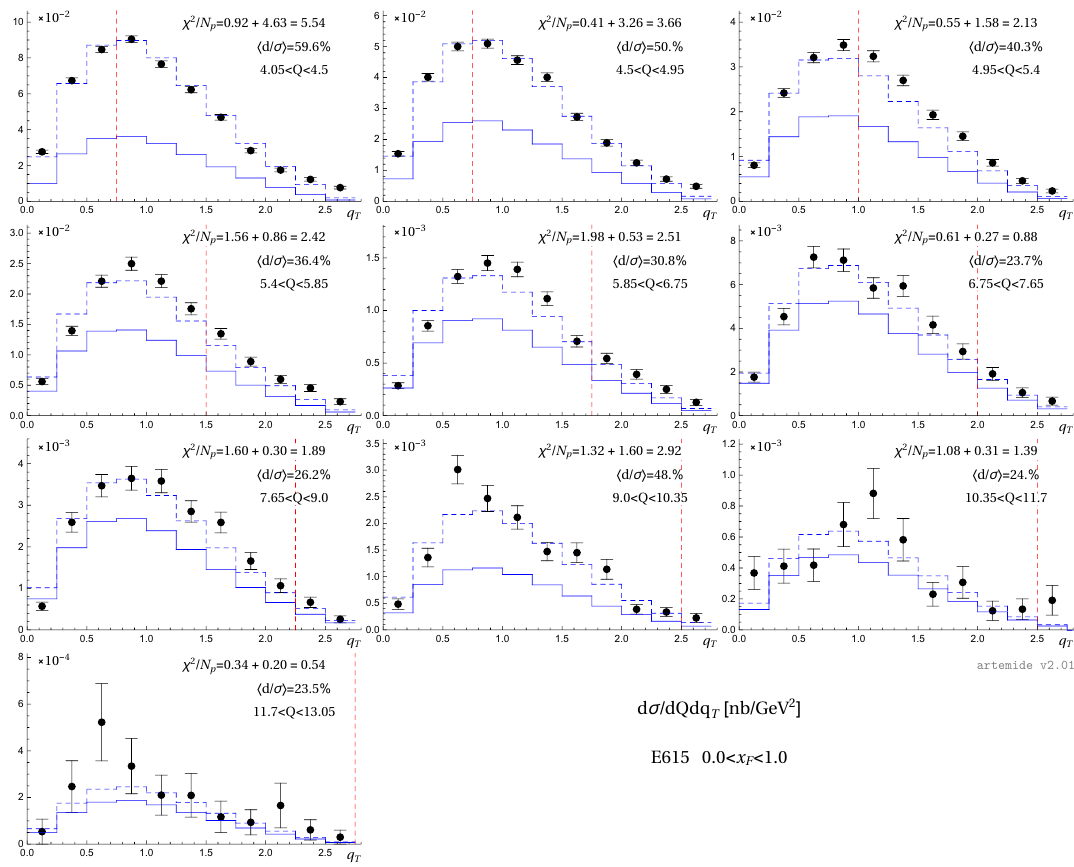
Figure 5 . Comparison of the theory prediction (solid line) to E615 di(cid:11)erential in Q . The dashed line is the theoretical prediction after the addition of systematic shifts d i . The values of the (cid:31) 2 and d i are calculated for the each Q -bin with 16% correlated error. The vertical dashed line shows the estimation of the boundary for TMD factorization approach. Note, that the bins with Q 2 (9 ; 10 : 35) and Q 2 (10 : 35 ; 11 : 7) lies in the region of (cid:7)-resonance, and could not be described by pure perturbative